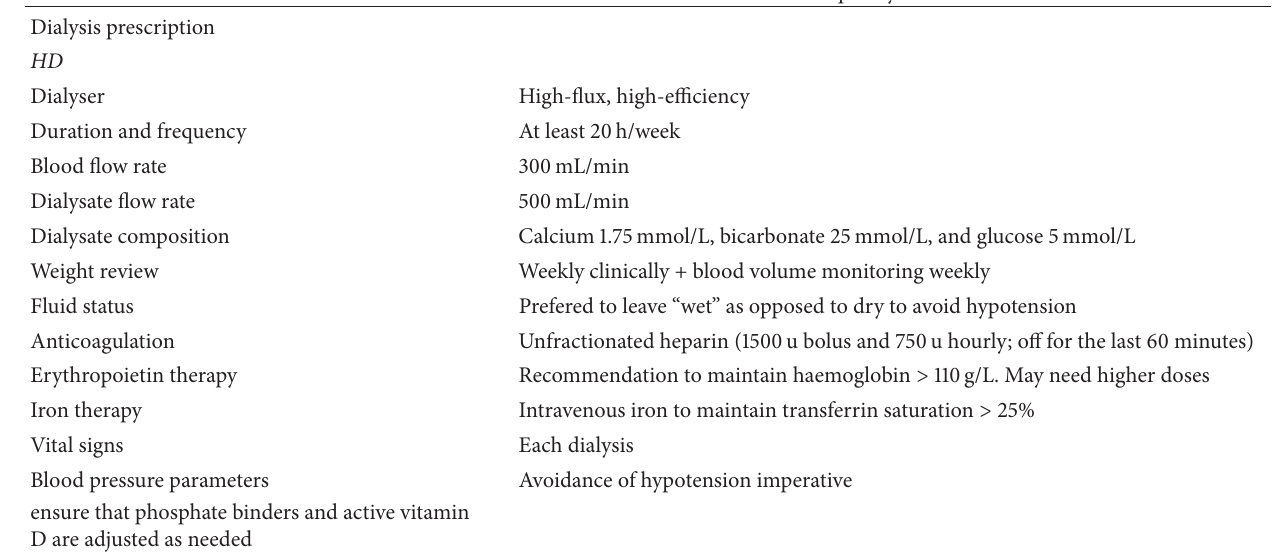
Table 3: Pregnancy and dialysis monitoring guidelines at the Renal Department of the Royal Brisbane and Women’s Hospital.